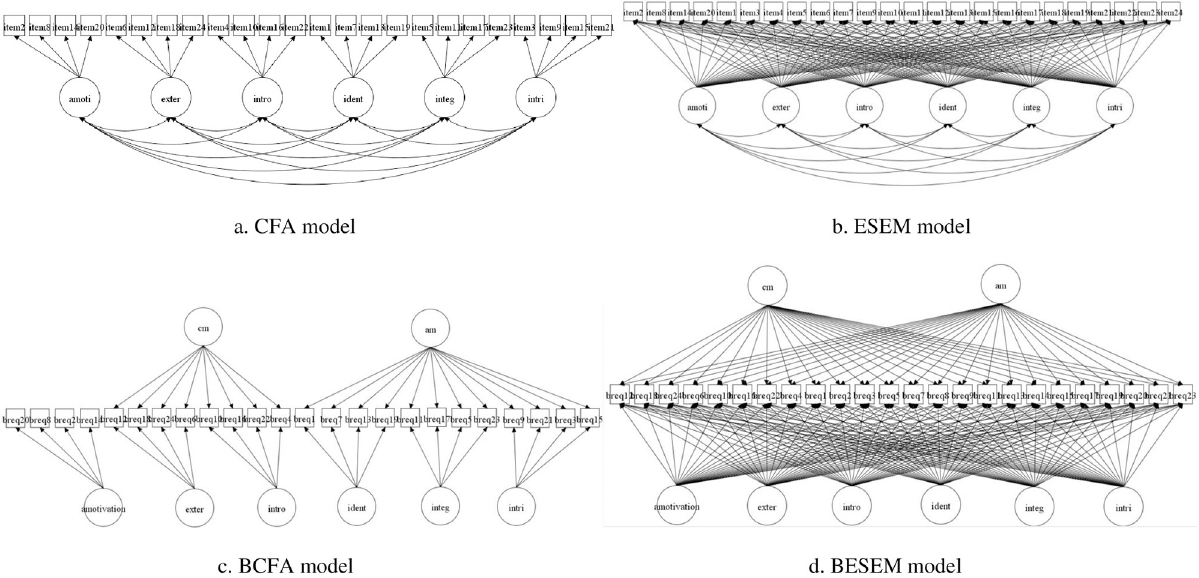
Fig 1. Graphical illustration of four alternative structural equation models. cm = controlled motivation; am = autonomous motivation; amoti = amotivation; exter = external regulation; intro = introjected regulation; ident = identified regulation; integ = integrated regulation; intri = intrinsic motivation; CFA = confirmatory factor analysis; ESEM = exploratory structural equation modeling; BCFA = bi-factor confirmatory factor analysis; BESEM = bi-factor exploratory structural equation modeling.